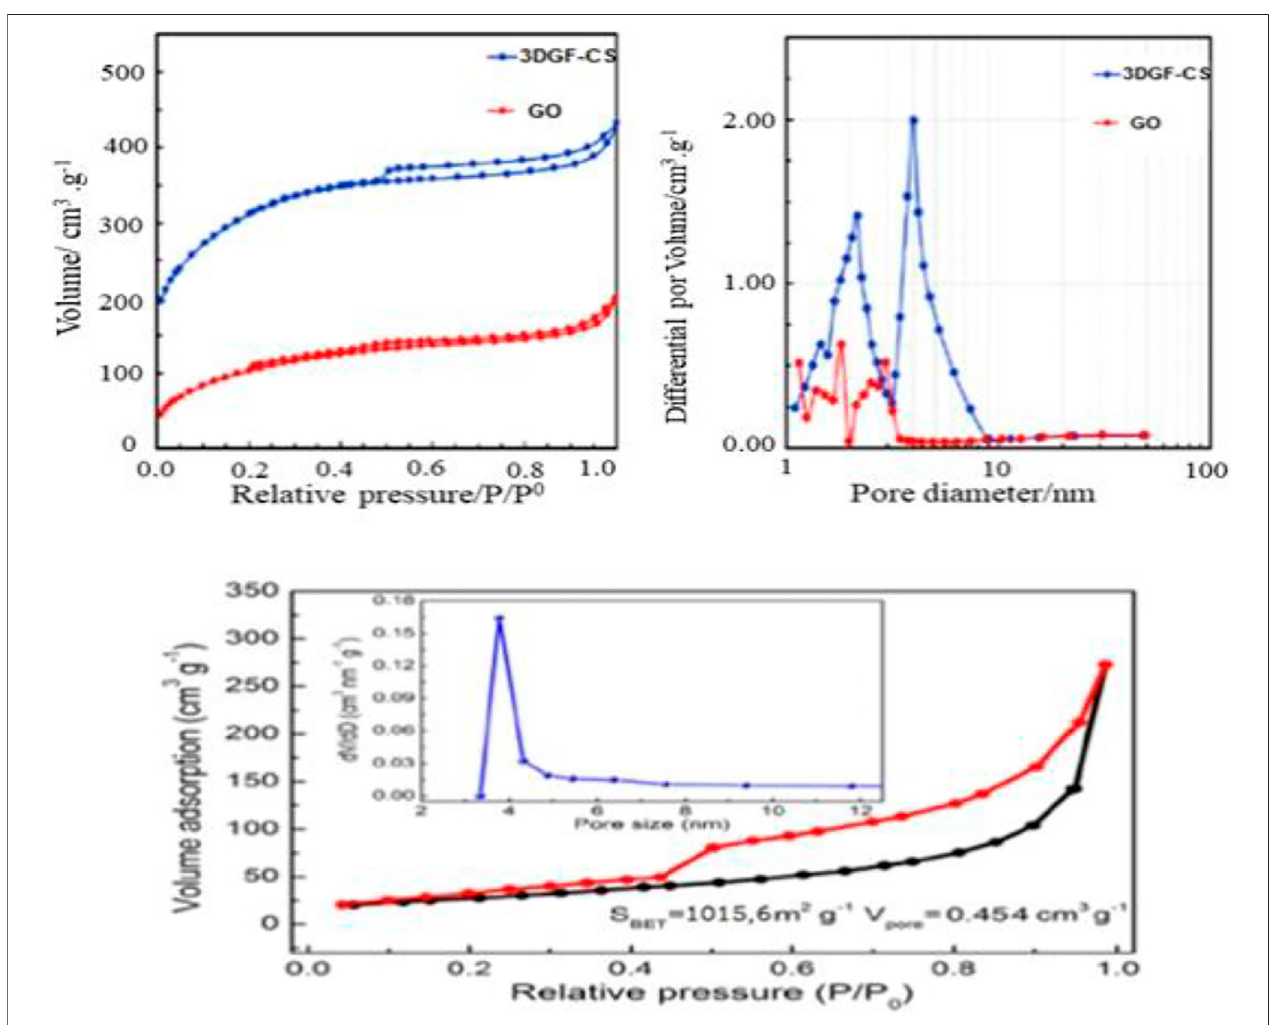
FIGURE 6 | Nitrogen adsorption and desorption isotherms of 3D